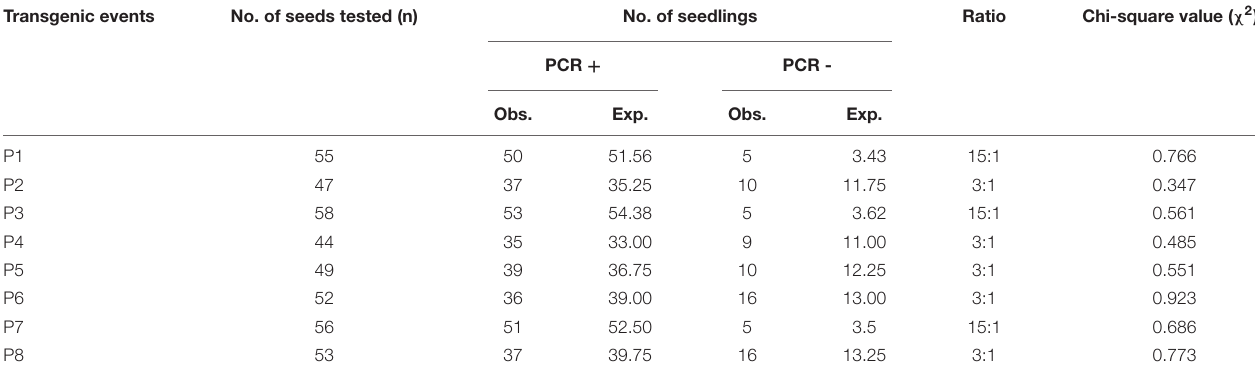
FIGURE 3 | PCR amplification of ∼ 700 bp GmIPK2_S gene plus GmFAD2-1 intron fragment from genomic DNA of T 0 transgenic plants. Lanes, M: 1 kb DNA ladder; 1–8: genomic DNA from each transformation event characterized; P: pCWAK-ipk2 plasmid DNA (positive control); NT: genomic DNA from non-transformed plant (negative control). Representative lanes were spliced from the original gel (Supplementary Figure S1). TABLE 1 | Segregation of bar gene amongst T 1 progenies of eight independent transformation events characterized in soybean cv. Pusa 16. Transgenic events No. of seeds tested (n) No. of seedlings